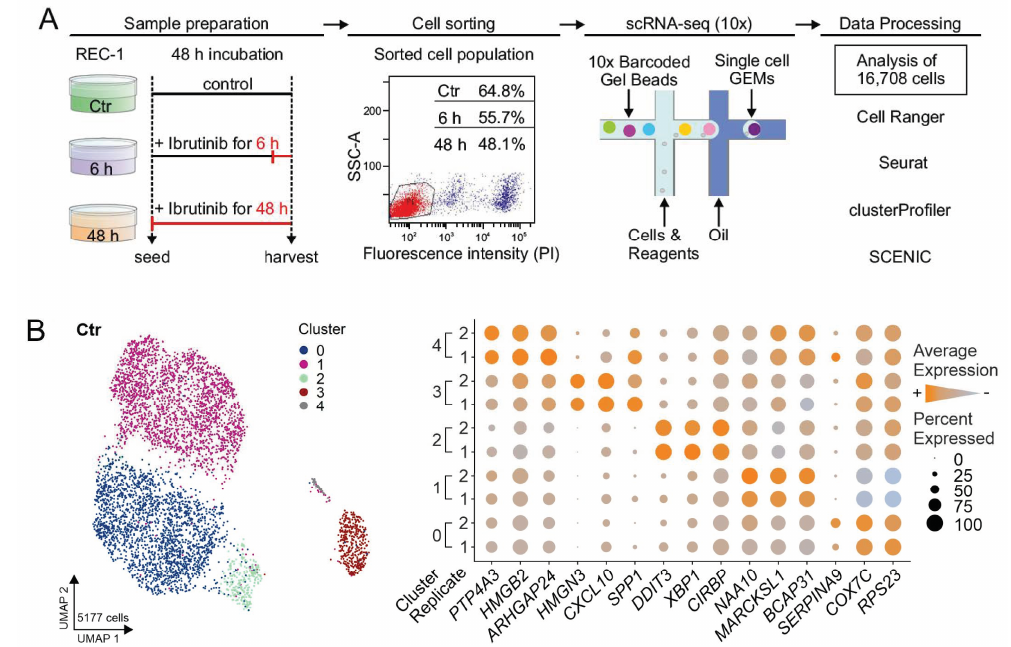
Figure 1. Overview of scRNA-seq approach and evaluation of reproducibility. ( A ) REC-1 cells were cultured for 48 h in total, one sample stayed untreated (Ctr), the second was treated for 6 h and the third for 48 h with ibrutinib (400 nM). Scatter plot (SSC-A vs. fluorescence intensity (propidium iodide)) of 48 h is shown representative for all treatments, cells of gate P1 (red) entered scRNA-seq (relative proportion of included cells are indicated for each sample). Droplet-based single-cell RNA sequencing was performed using the 10x Genomics platform with encapsulation of single cells in GEMs (gel bead-in-emulsions). The data was analyzed implementing Cell Ranger (10x Genomics), and R packages such as Seurat, clusterProfiler, and SCENIC; ( B ) uniform manifold approximation and projection (UMAP) representation visualized the five subpopulations in the aggregated (replicate 1 and 2) and cell cycle regressed data set of Ctr and the corresponding dot plot shows the expression of selected top 10 marker genes for every subpopulation; size of dots refers to the percentage of cells expressing the gene, color intensity represents the average expression level.